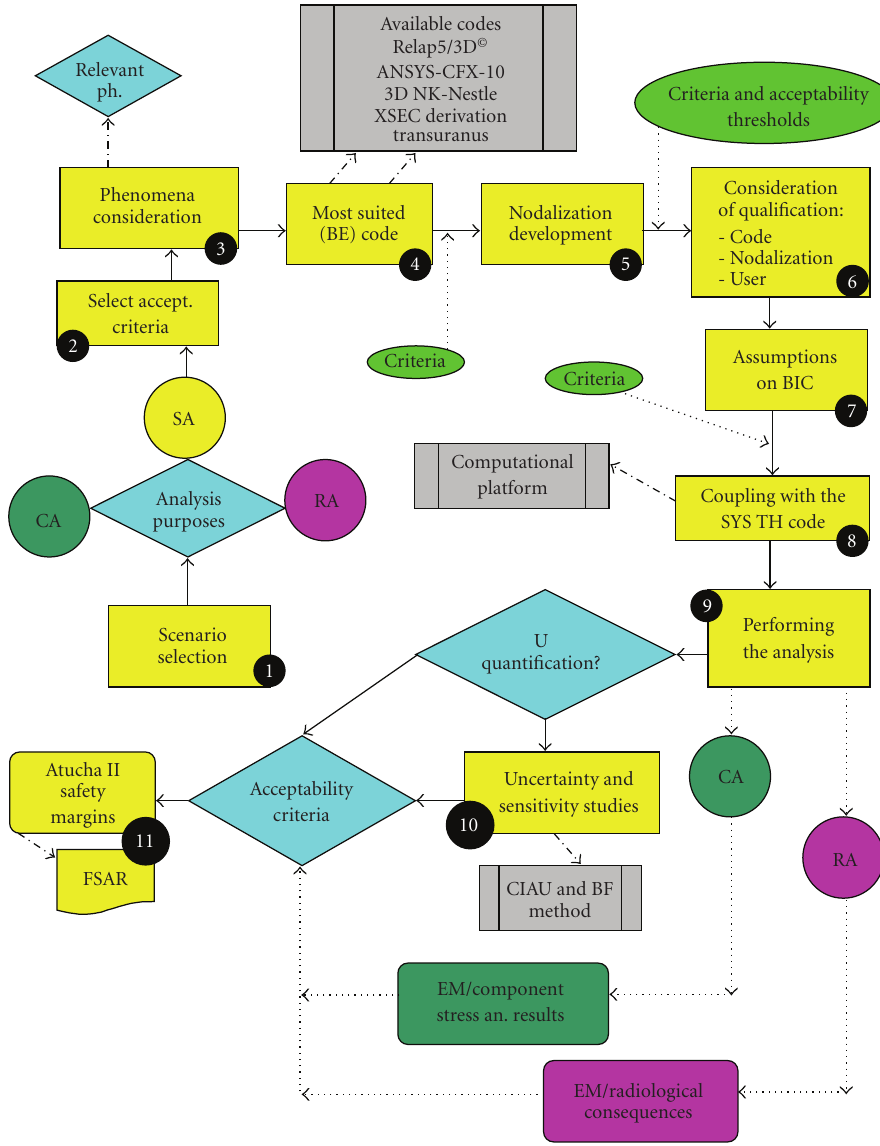
Figure 1: The BEPU flow